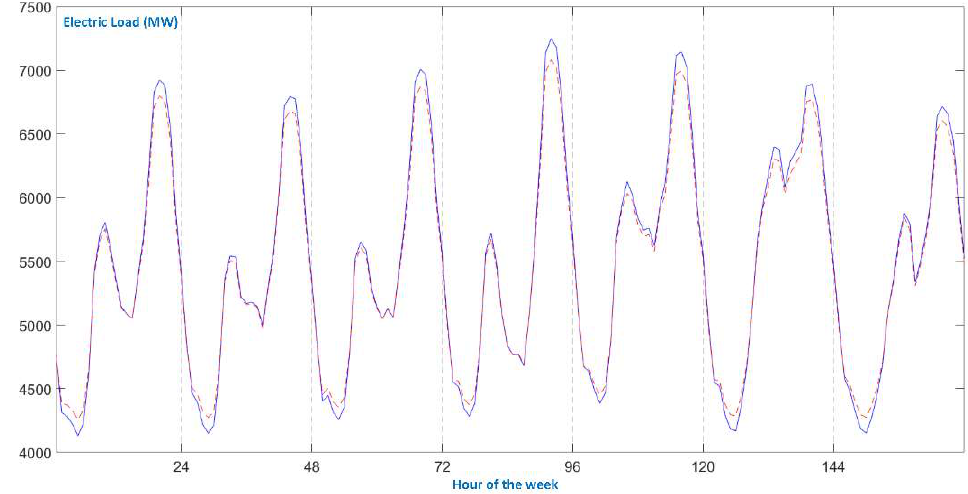
Figure 9. A winter week. ( a ) Blue solid line: actual electric load. ( b ) Red dotted line: ReNFuzz-LF’s output.